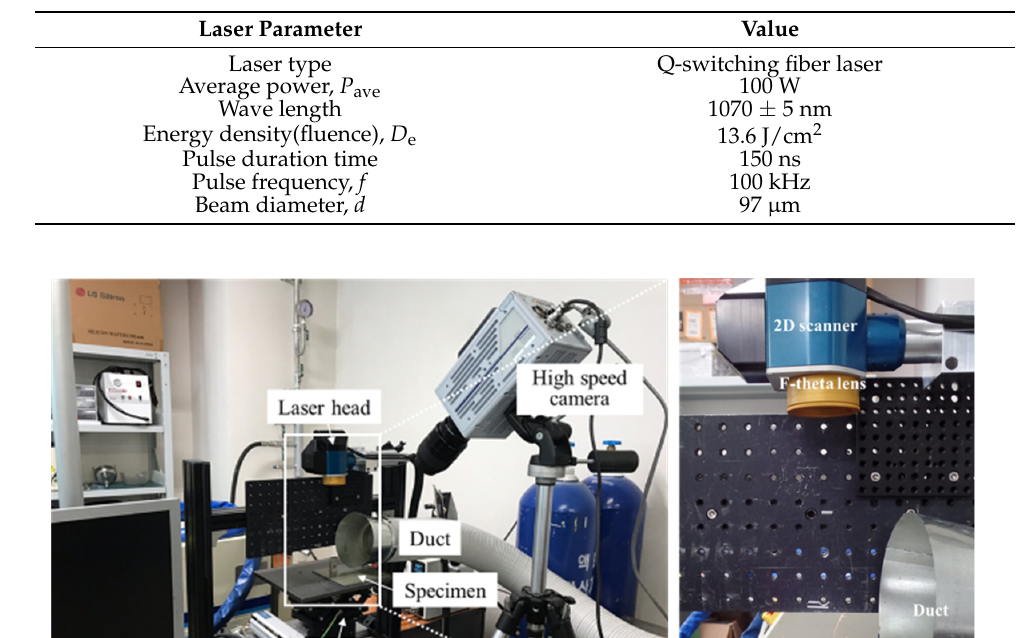
( d ) Wave clean Figure 3. Schematic of the laser beam scanning direction and high-speed camera photography based on beam scanning patterns; ( a ) Line, ( b ) Circle, ( c ) Infinity, ( d ) Wave clean.